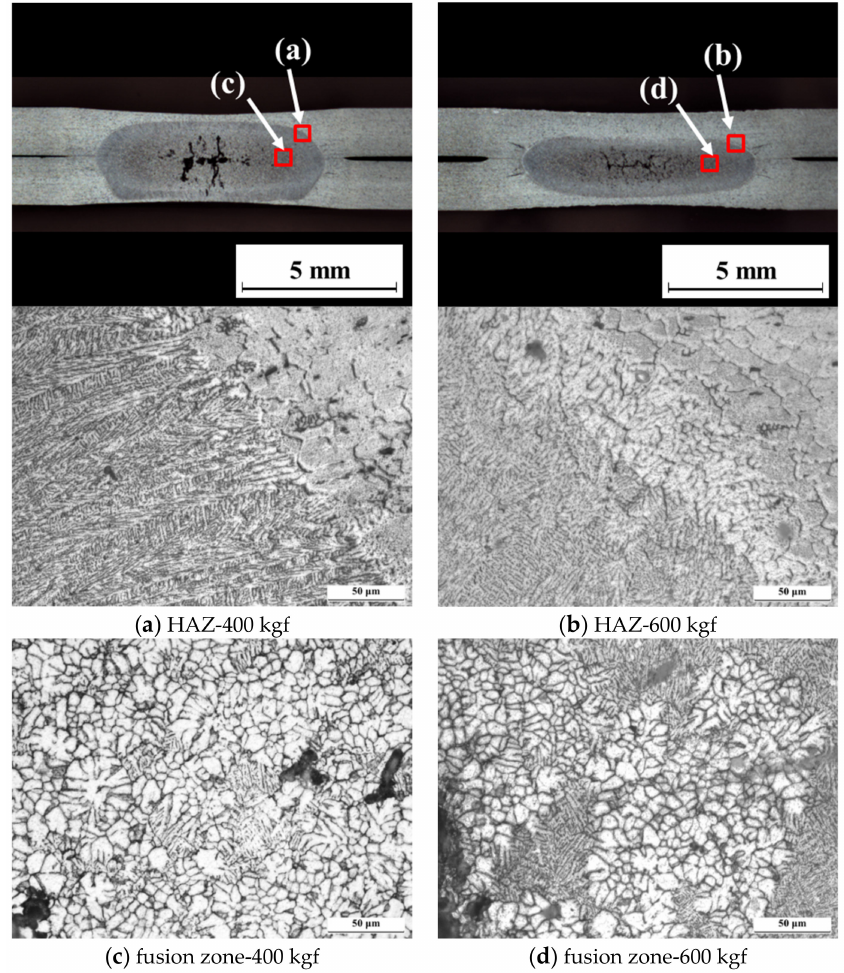
Figure 5. Microstructures of heat-a ff ected zone (HAZ) and fusion zone obtained with the as-received electrode at electrode forces of 400 kgf and 600